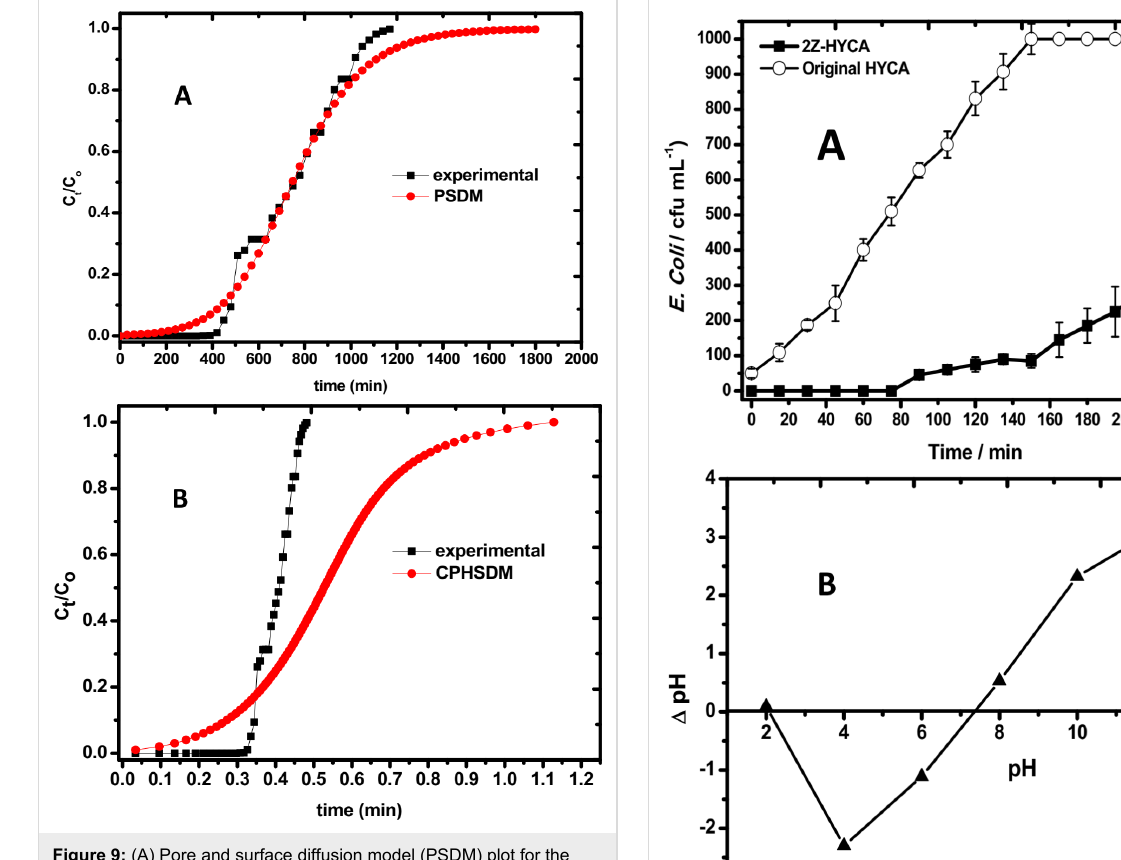
Figure 9: (A) Pore and surface diffusion model (PSDM) plot for the removal of 4-nitrophenol from aqueous solution by 2Z-HYCA@650 °C loaded into a fixed-bed reactor ( C o = initial concentration of 4-nitro- phenol at time 0 and C t = concentration of 4-nitrophenol at time t ). (B): Constant pattern homogeneous surface diffusion model (CPHSDM) plot for the removal of 4-nitrophenol from aqueous solu- tion by 2Z-HYCA@650 °C loaded into a fixed-bed reactor ( C o = initial concentration of 4-nitrophenol at time 0 and C t = concentration of 4-nitrophenol at time t ).